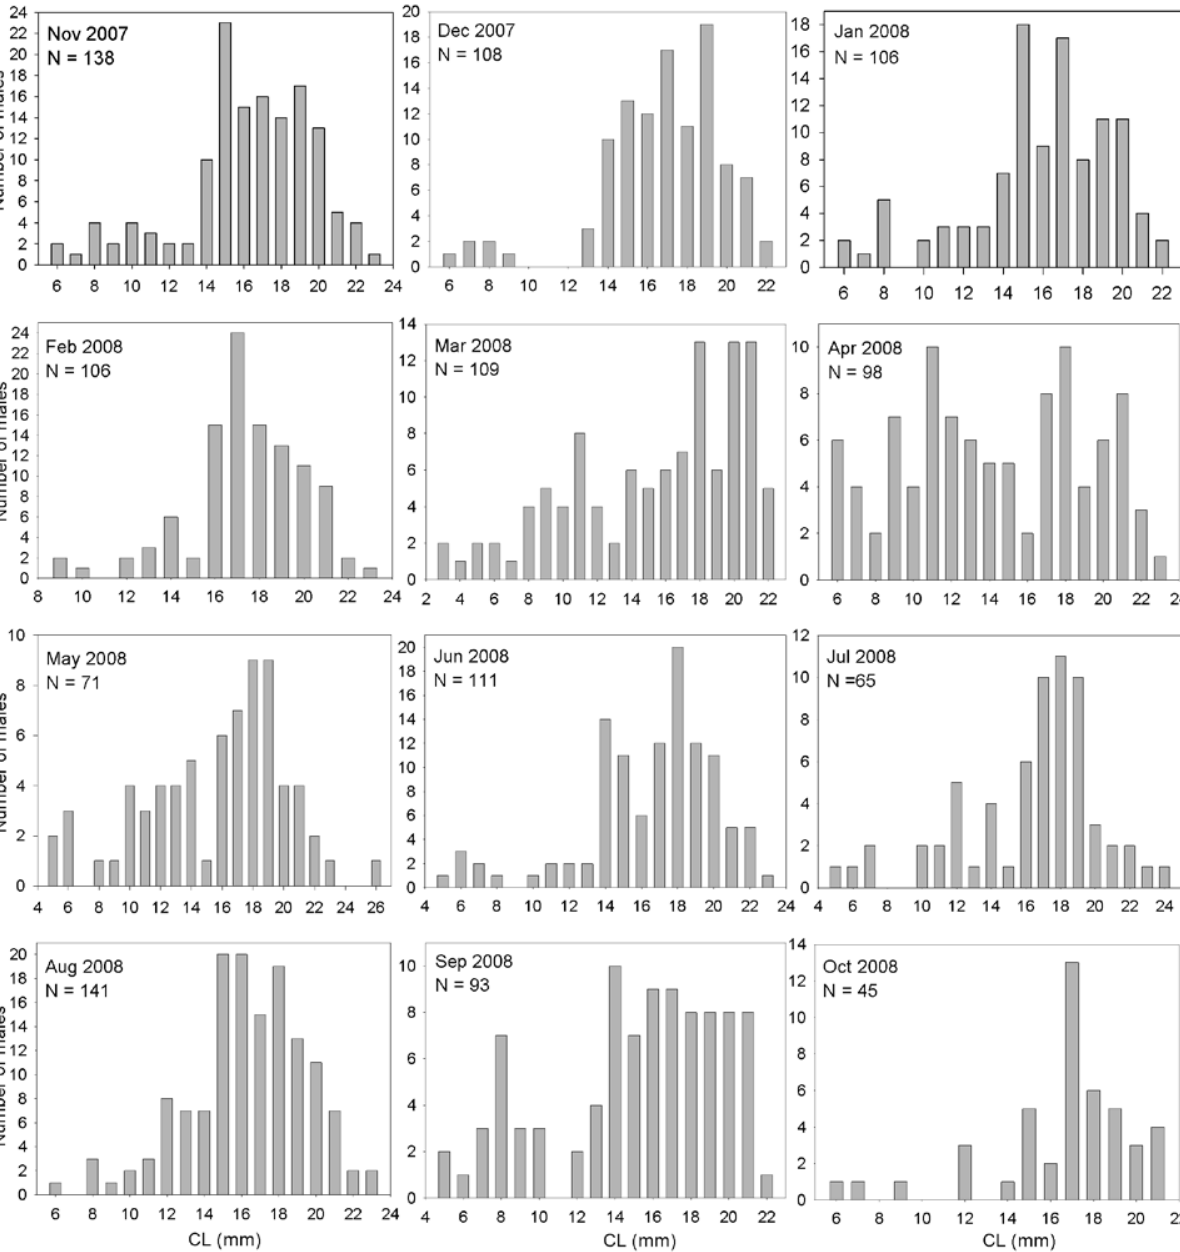
Figure 2. Absolute frequency distribution of cephalothoracic length (CL) (mm) classes of Aegla georginae males, Perau Creek, Ibicuí Basin,